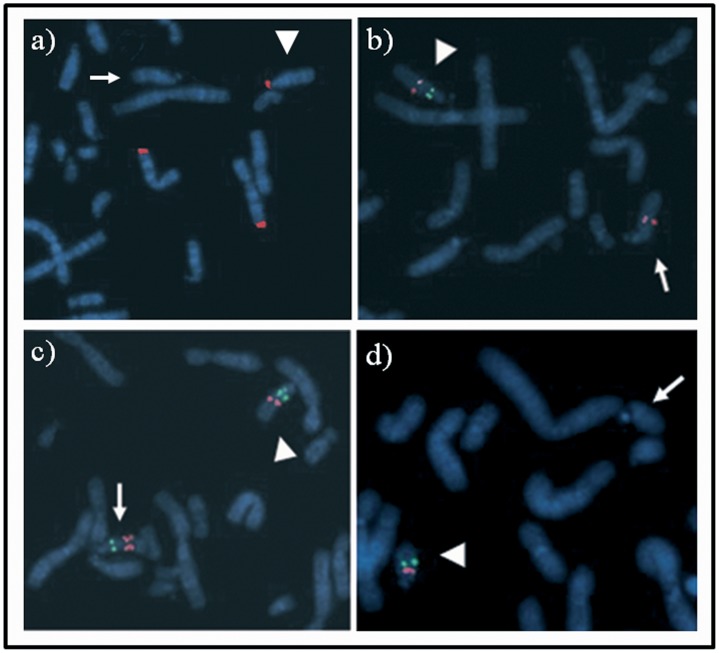
FISH results.a) FISH with specific subtelomeric 7q probe (red) confirmed the presence of the unbalanced translocation both in the patient and mother. b) FISH with oligonucleotide-based probe 15q13.3 (green signal) and BAC RP11-231A23 (red signal) on the metaphase of the mother in family 1 showing the deletion on a chromosome 15 (arrow). The arrowhead indicates the normal chromosome 15. c) FISH with oligonucleotide-based probe 15q13.3 (green signal) and BAC RP11-231A23 (red signal) on the metaphase of the proband in family 1 showing the duplication on a chromosome 15 (arrow). The arrowhead indicates the normal chromosome 15.FISH performed with the same probes on the metaphase of the mother showed normal signals only on both chromosome 15 (data not showed). d) FISH with oligonucleotide-based probe 22q11.21 (red signal) and BAC RP11-1143M16 (green signal) on the metaphase of the proband in family 2 confirming that large and short deletions are on the same chromosome 22. Arrowhead shows the normal chromosome 22 and arrow the deleted chromosome 22.